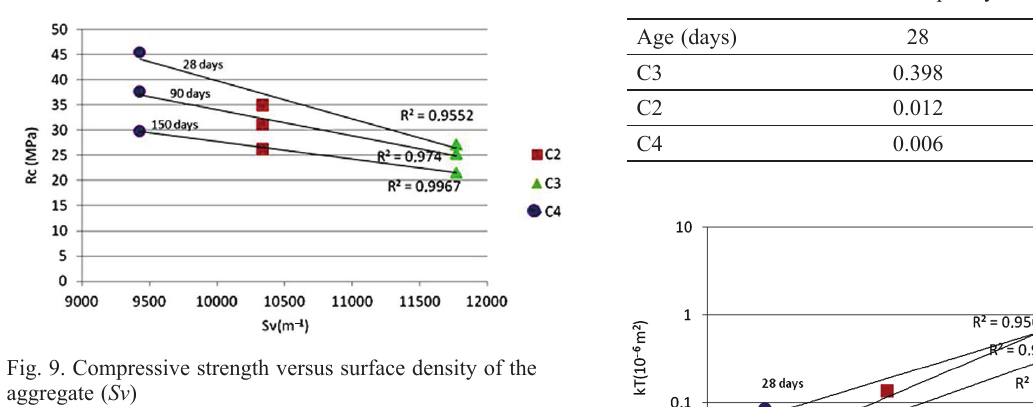
Fig. 10. Sorptivity coefficient vs. surface density of aggregate ( Sv ) Table 9. Standard deviation of sorptivity coefficient